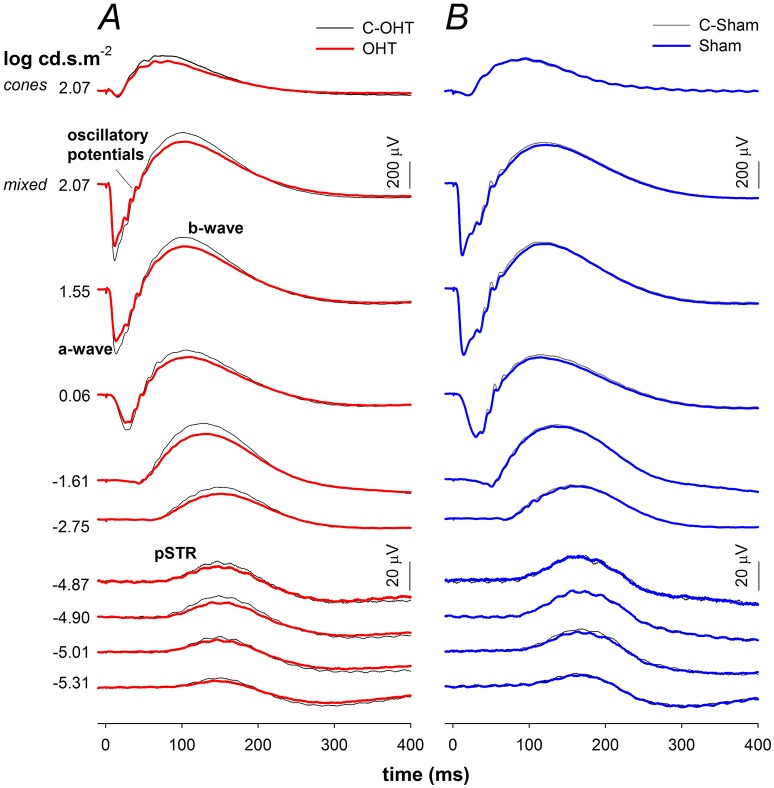
Effect of chronic IOP elevation on ERG waveforms. (A) Ocular hypertensive (OHT, red traces, n = 23) and control eyes (C-OHT, black traces) (B) Sham (blue traces, n = 17) and control eyes (C-Sham, black traces).